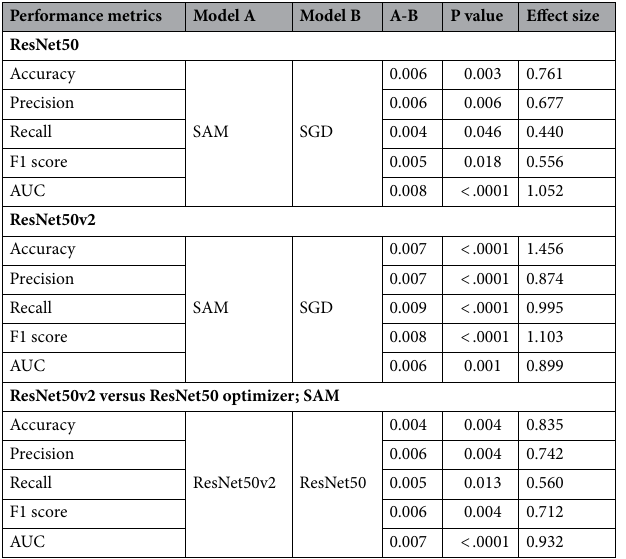
Table 3. Statistical evaluation of ResNet50 and ResNet50v2 with the SAM and SGD optimizers in contact analysis. AUC, area under the receiver operating characteristics curve.